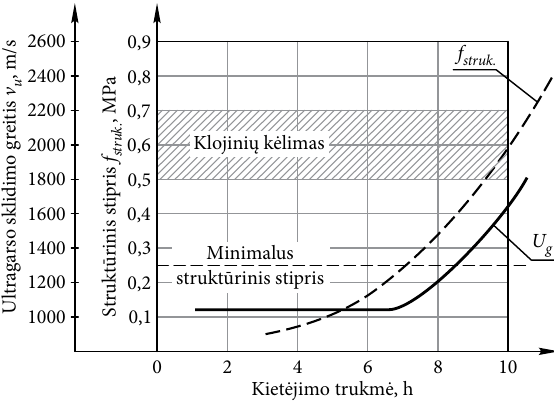
Fig. 6. Dependence of parameters governing concreting process and time (the first concrete composition)